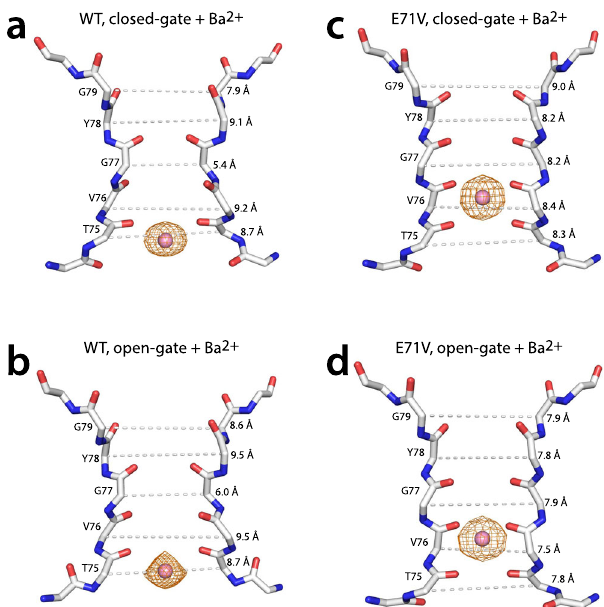
Fig. 4 X-ray structures of barium-bound WT and E71V KcsA. a Closed- gate and b open-gate structures of WT KcsA with Ba 2 + bound at the S4 position of the selectivity fi lter. The fi lter is sharply constricted at the level of G77 in both the closed-gate and in the open-gate structures. c Closed- gate and d open-gate structures of E71V KcsA with Ba 2 + bound at the S3 position of the selectivity fi lter. The fi lter is conductive in the closed-gate structure and narrows in the open-gate structure. C α -C α distances between like-residues in opposing protomers are open-gate E71V structures, with and without Ba 2 + , show the same conformational change of the W67 sidechain if compared to WT KcsA.